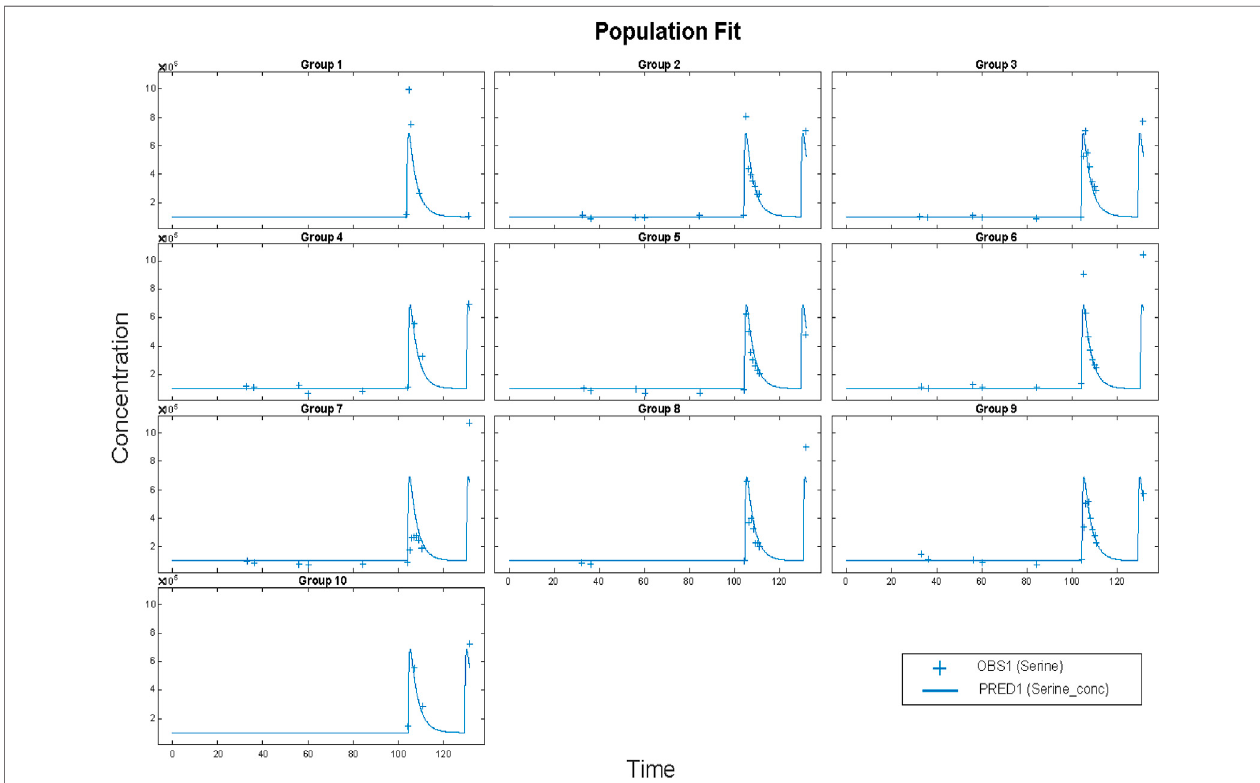
FIGURE 5 | Results for Clinical data (+) and model simulation (line). Time vs concentration data and fi tted results. Each plot is an individual ’ s data. The range of concentrations (vertical lines) are from 0 to 1,000 umol/L. All subjects fi t using a population methods and a combined (constant plus proportional) error model in SimBiology ® . Clinical data (+) and model simulation